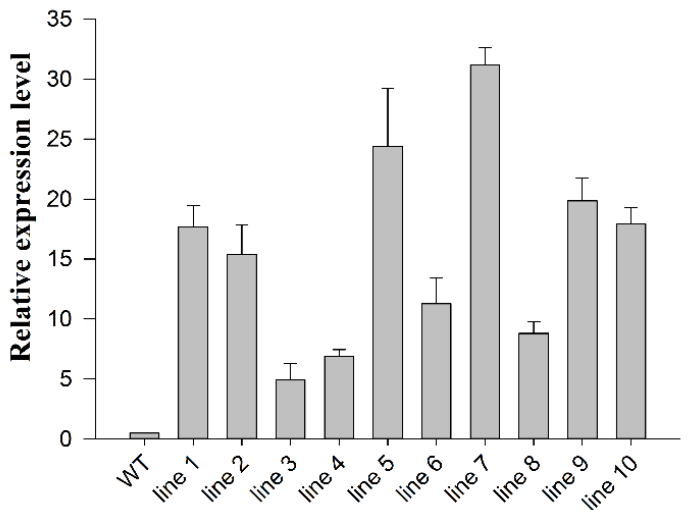
Figure 3. The relative expression level of ScABI3 in transgenic alfalfa. WT: wild-type alfalfa; line 1-10: transgenic alfalfa.